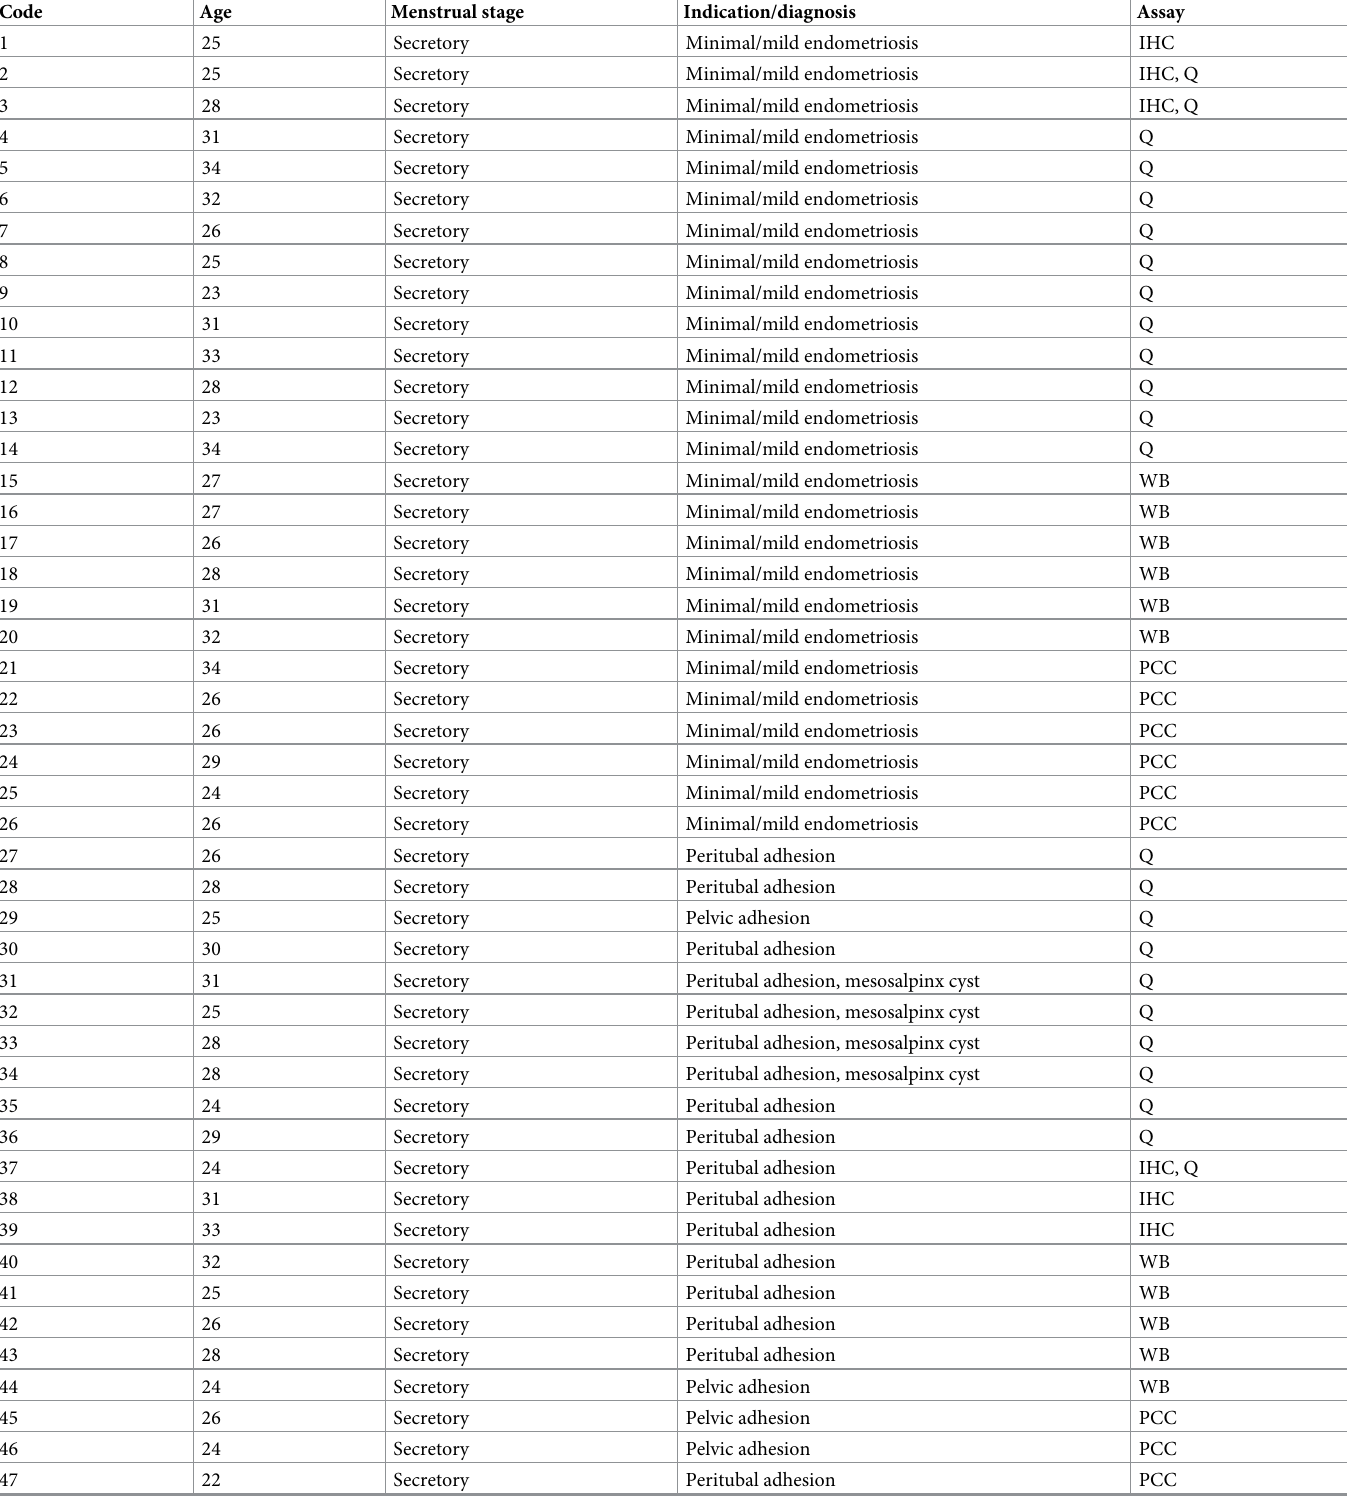
Table 1. Details of patient samples used in this